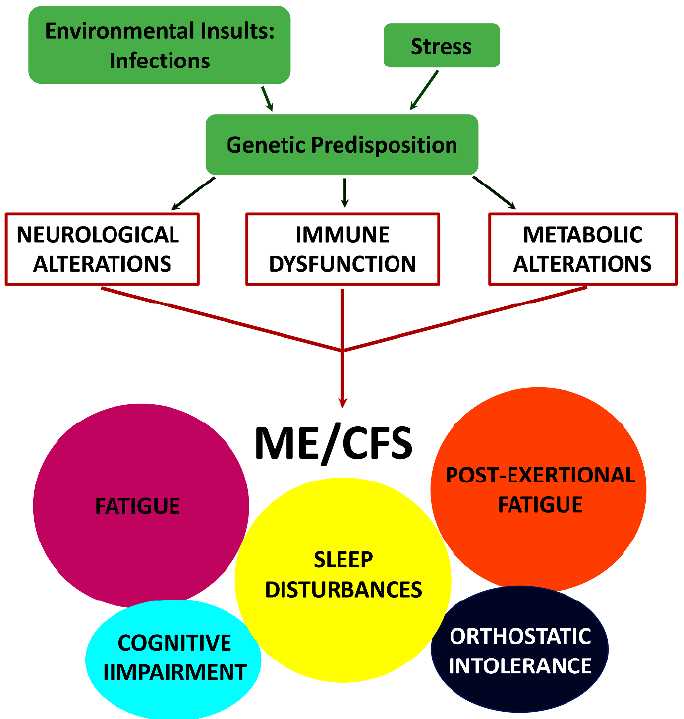
Figure 1. Model depicting how the combined effect of environmental insults, and stress in genetically susceptible individuals can trigger neurological, immune and metabolic dysfunction, which together could contribute to the symptomology observed in ME/CFS [4].